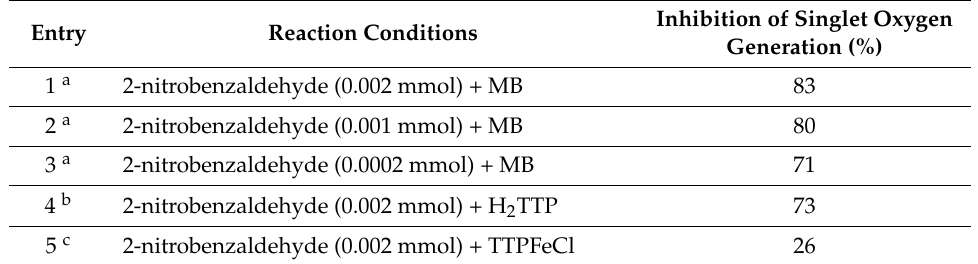
Table 1. Effect of 2-nitrobenzaldehyde on inhibition of singlet oxygen generation at different conditions.